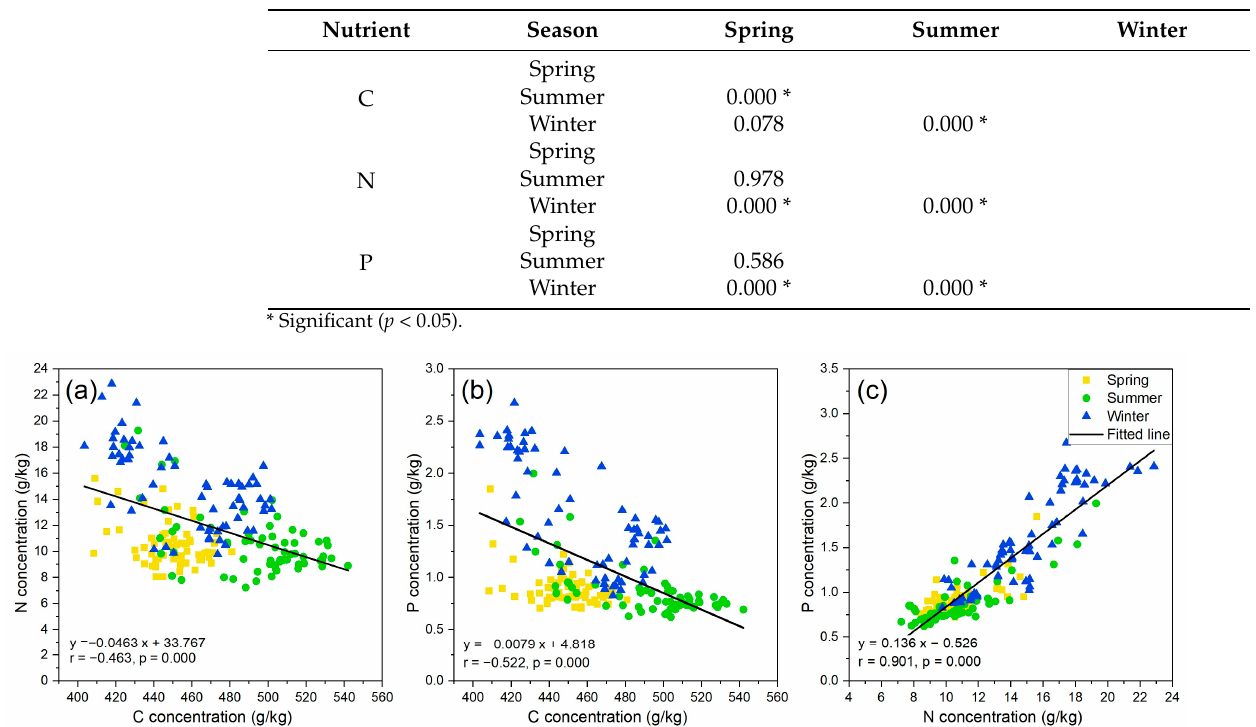
Figure 2. Intercorrelation of leaf C–N concentration ( a ), leaf C–P concentration ( b ), and leaf N–P concentration ( c ) with all the samples ( n = 172), respectively.